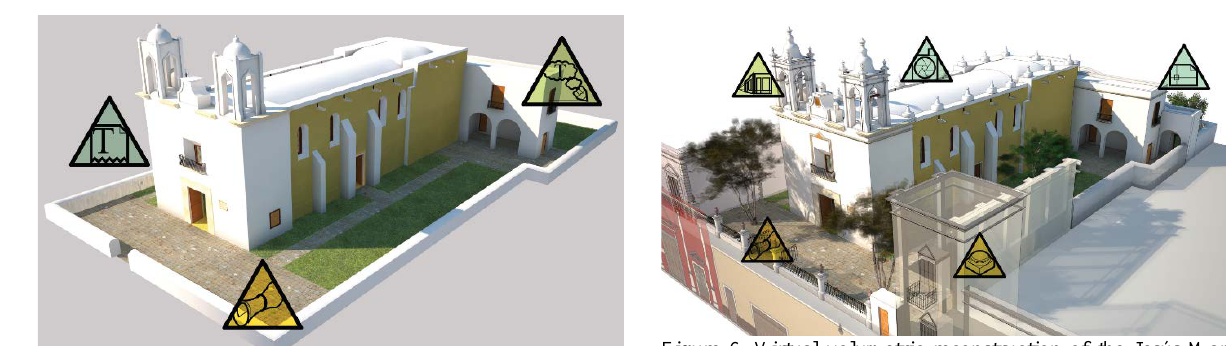
Figure 6. Virtual volumetric reconstruction of the Jesús María temple, evidencing the sources of the various parts of the Figure 5. Reconstructive hypothesis of the El Dulce Nombre de Jesús temple, based on documentary sources and retrospective inference from the subsequent stages.